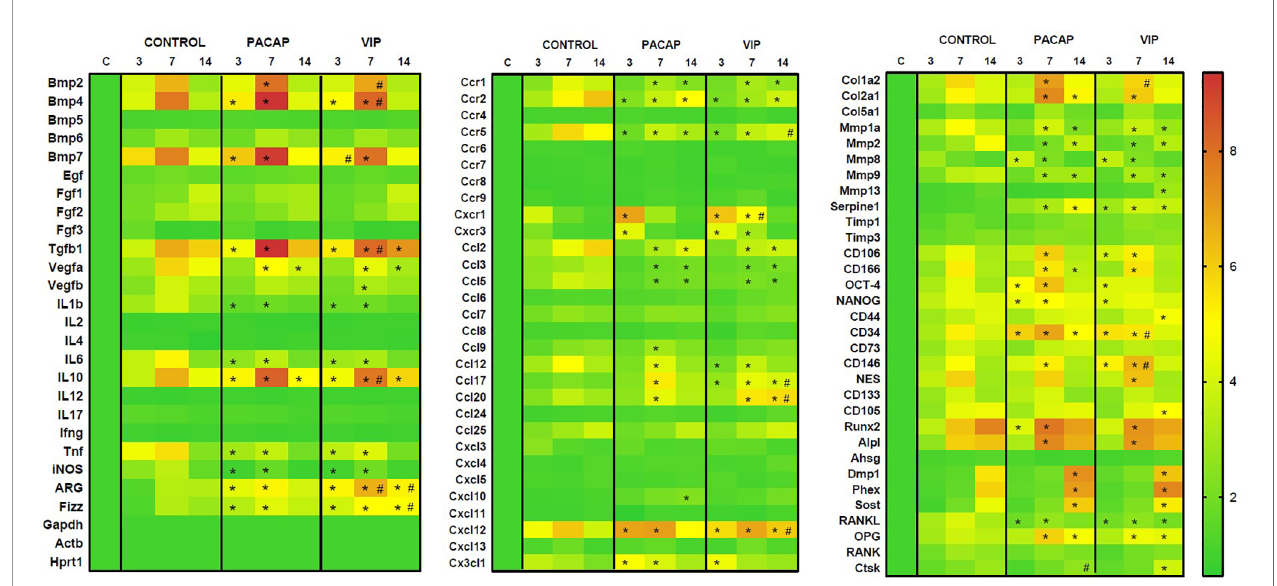
FIGURE 1 | Molecular analysis (Real Time PCR Array) using heat map to quantify the expression of the growth factors, extracellular matrix markers, bone markers and cytokines in bone healing process among control, VIP and PACAP treated groups. Results were obtained when comparing the relative expression of the different groups norm normalized by Gapdh, Actb, and Hprt1 (* represents the differences between the control group; # represents the difference between the VIP and PACAP